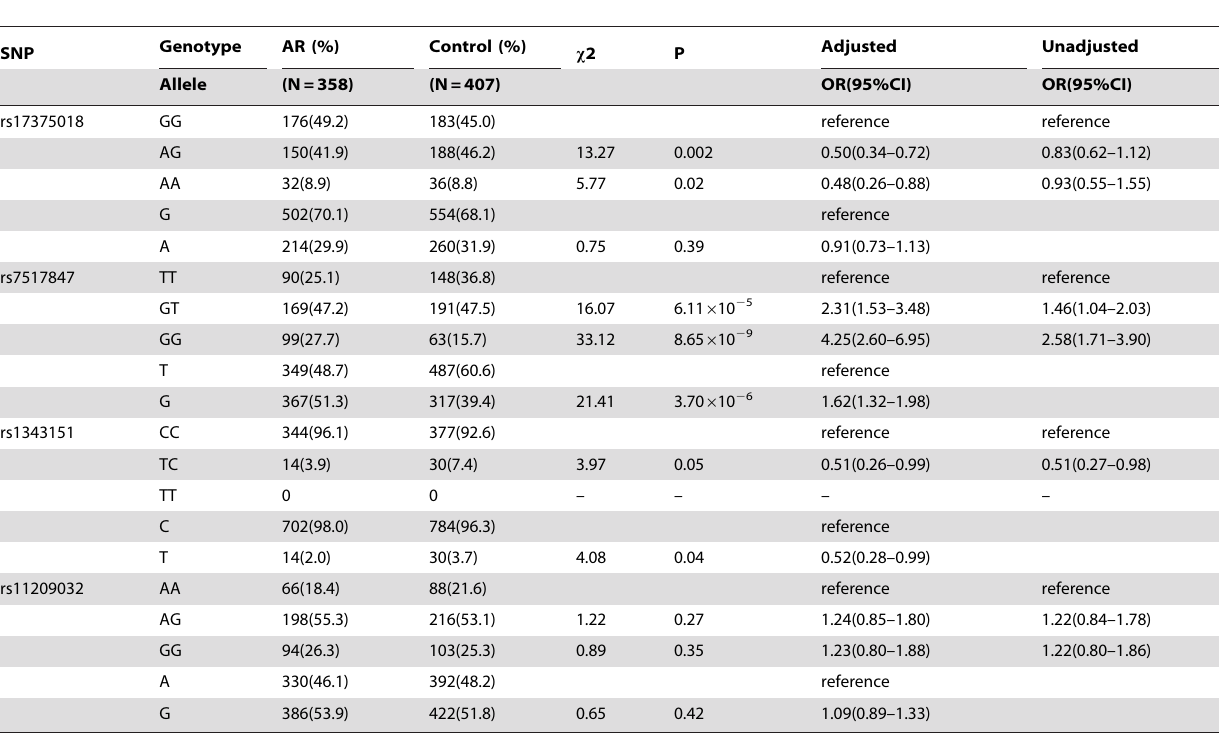
Table 3. Frequencies of alleles and genotypes of IL-23R polymorphisms in AR patients and control